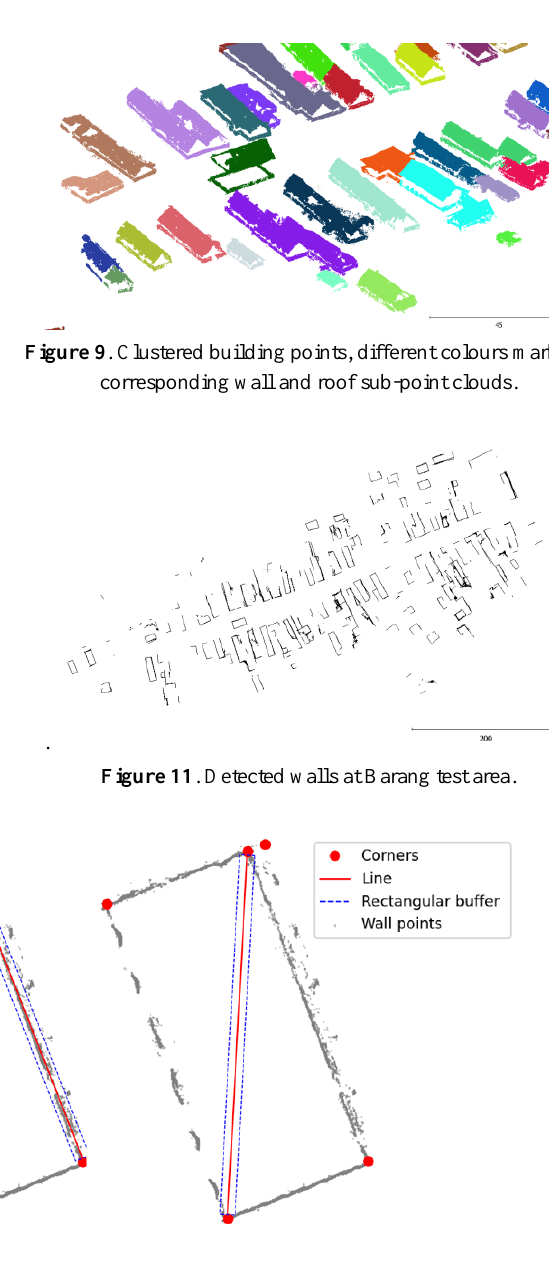
density of the points (points/m 2 ) whether it is a real edge (Figure 10).